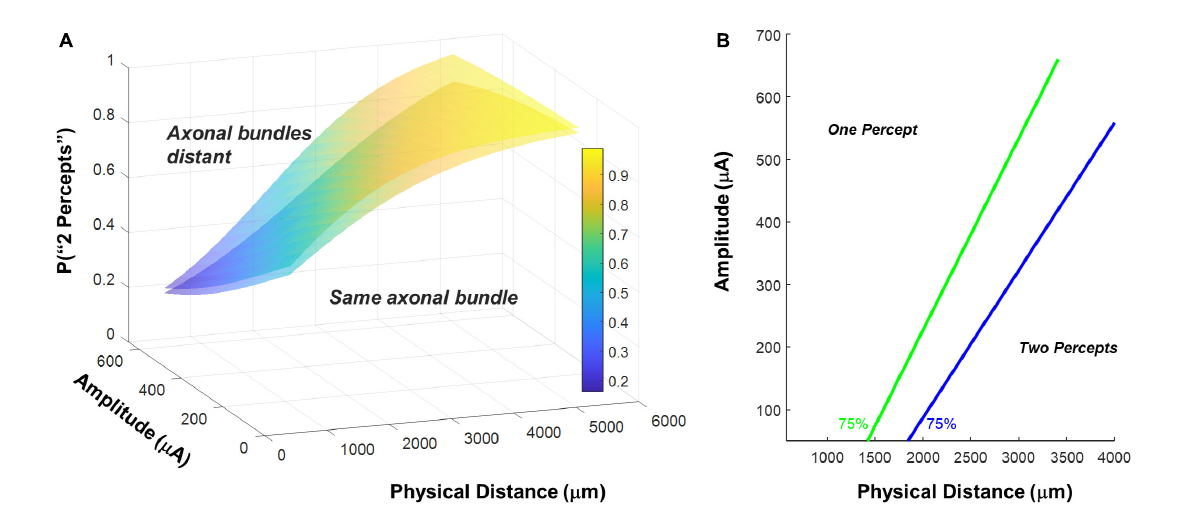
FIGURE8 (A) Surfaces based on fitting the probability of reporting 2 percepts using logistic regression with amplitude and physical distance as fixed factors. Having fixed the weights for amplitude and physical distance, we included distance to axon as a factor. The lower surface represents predictions for distance to axon = 0 (the two electrodes fall on the same axonal bundle), the upper surface represents predictions for distance to axon = physical distance (minimizing axonal stimulation). (B) 75% two-point discrimination iso-performance curves as a function of amplitude and physical distance for distance to axon = 0 (the two electrodes fall on the same axonal bundle), and distance to axon = physical distance (minimizing axonal